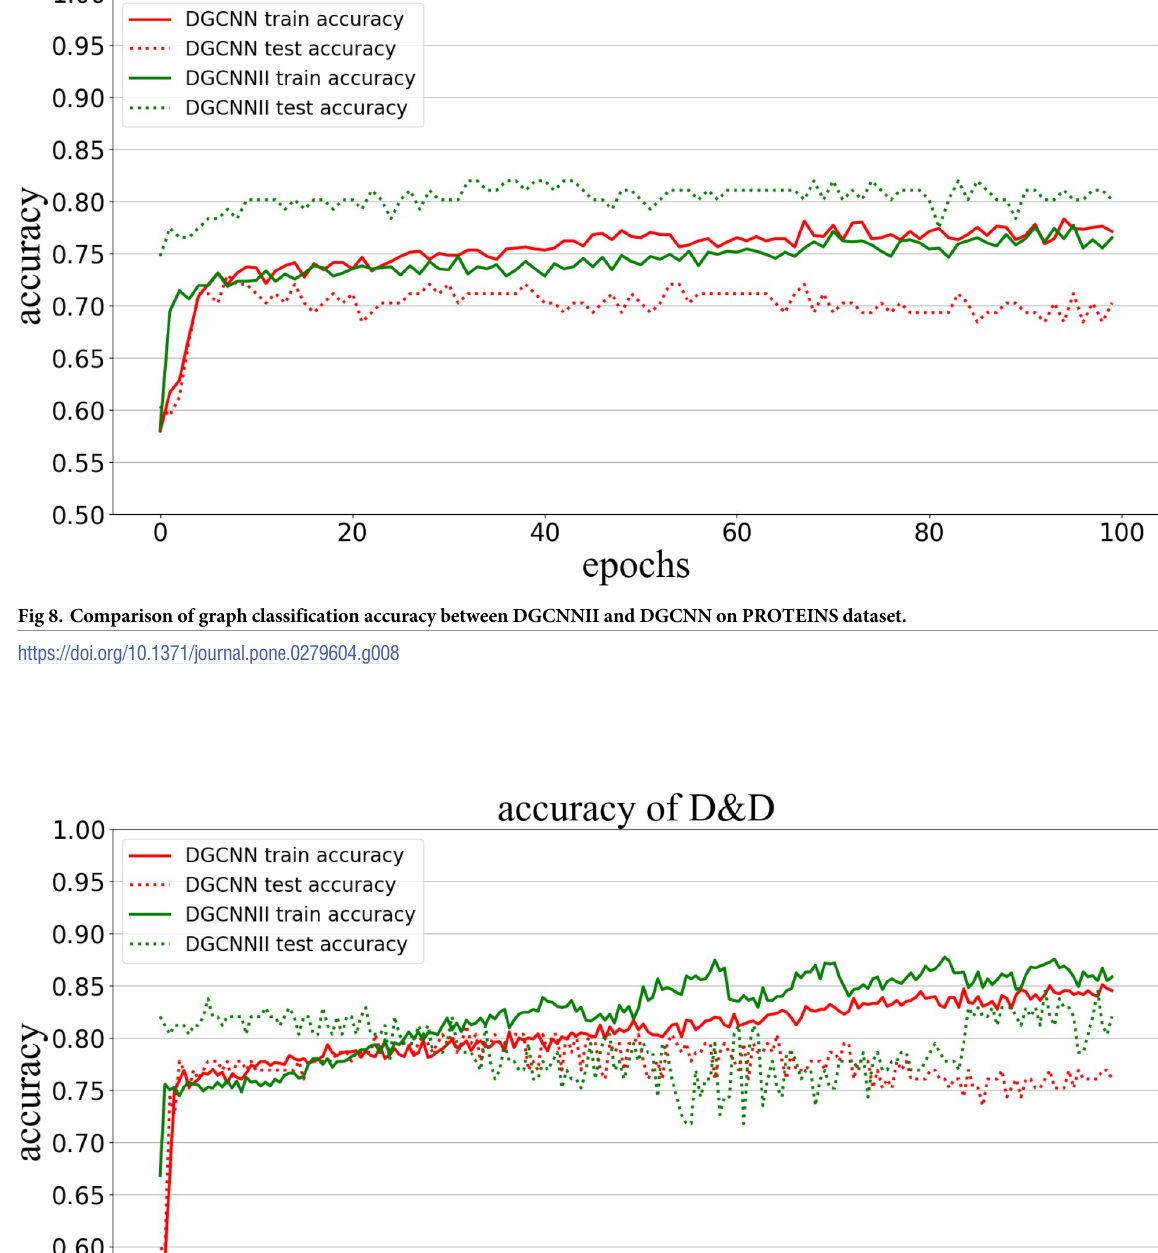
PLOS ONE | https://doi.org/10.1371/journal.pone.0279604 March 10, 2023 23 /